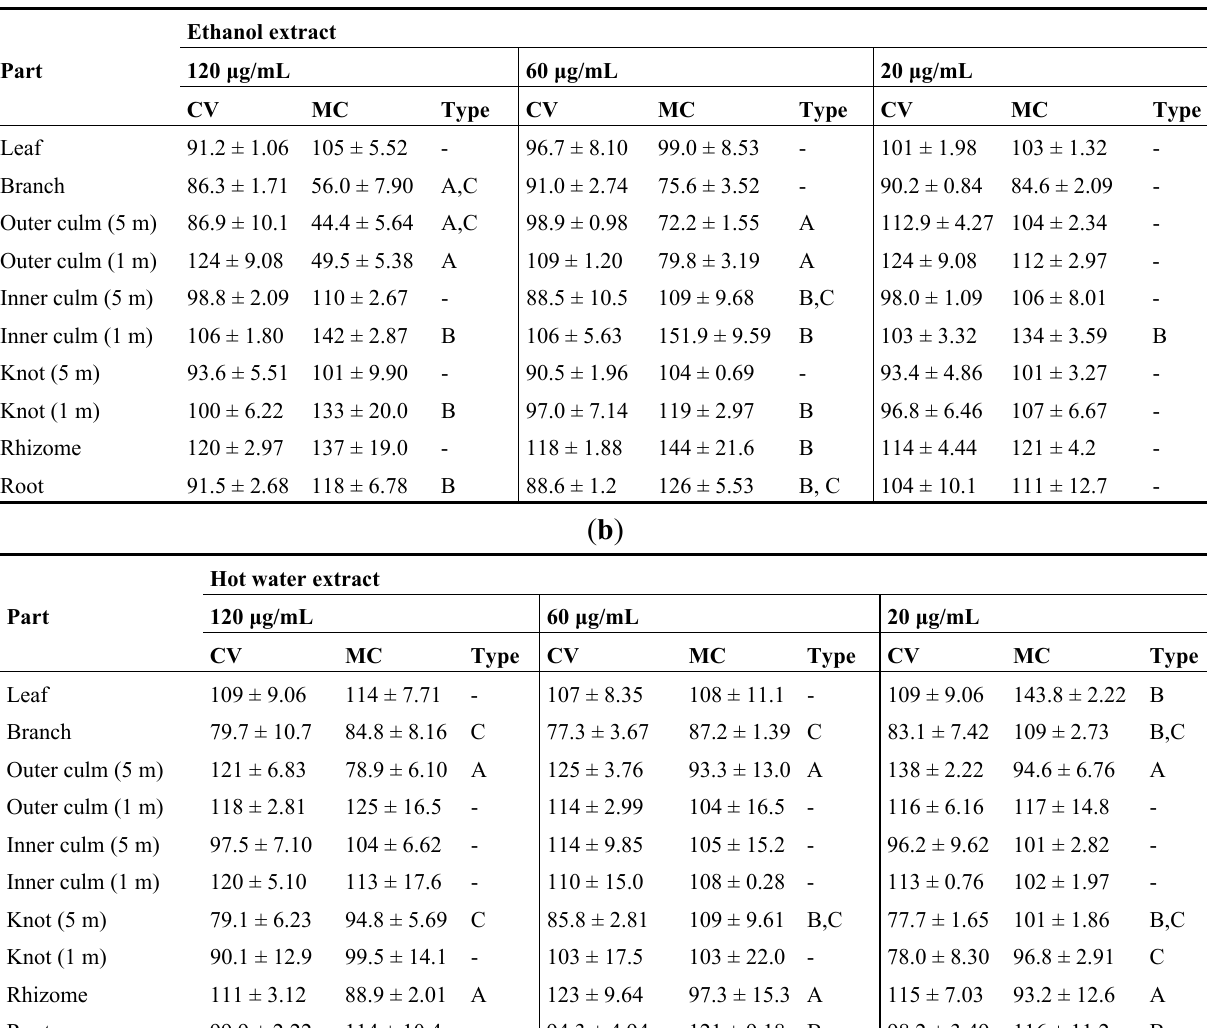
Table 1. Effect of the ( a ) ethanol extracts and ( b ) the hot water extracts of P. pubescens on melanin biosynthesis and cell proliferation of B16 melanoma